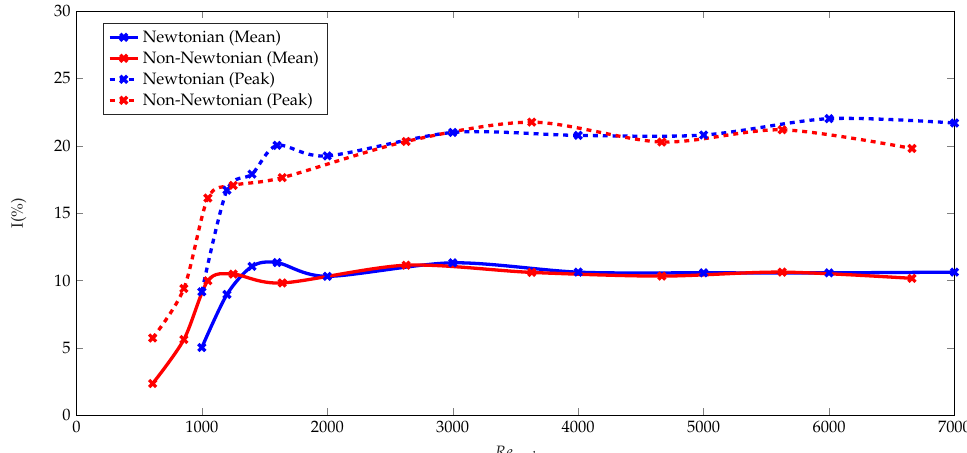
Figure 19. Turbulence intensity of Newtonian and shear-thinning blood rheology plotted against modified Reynolds number Re . mod